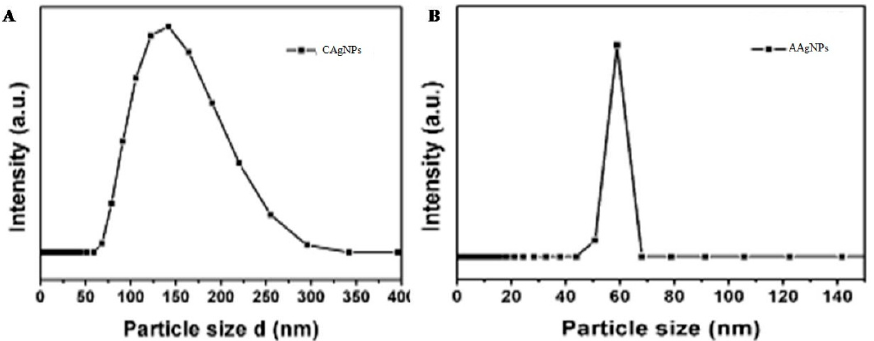
Figure 3. The hydrodynamic size determination of green-synthesized Ag NPs of Catharanthus roseus ( A ) and Azadirachta indica ( B ) by dynamic light scattering (DLS).